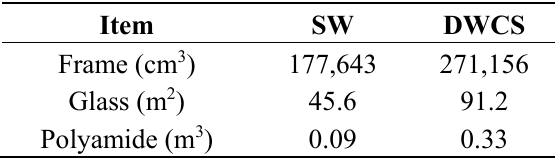
Table 1. Materials in windows per residential